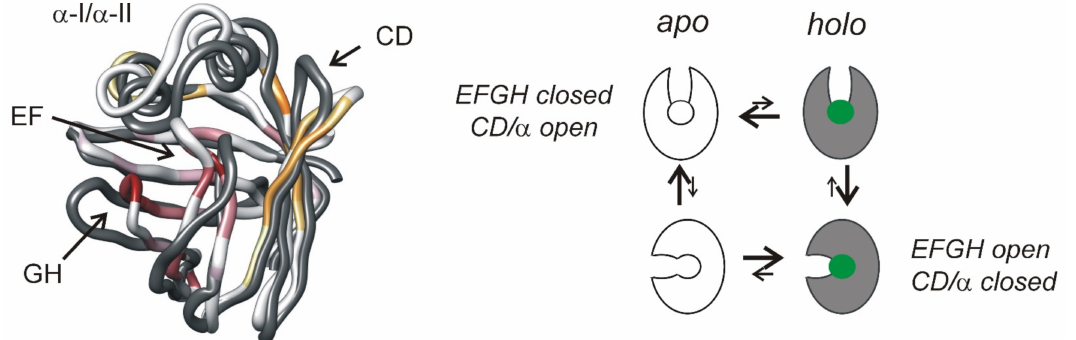
Figure 7. Proposed mechanism of bile salt entry. Superimposed backbone trace of the apo (PDB: 1o1u [39], white with color) and the holo form (PDB: 2mm3 [25], grey) of hI-BABP showing the enlarged gap between the E/F and G/H turns in the bound state connecting the binding cavity with the bulk phase. Note the accompanying closing of the helical cap upon bile salt binding. The color coding in the apo state reflects the chemical shift difference between the ground and the low- populated higher energy state inferred from the CPMG relaxation dispersion measurements (Figure 6) for the two clusters (orange and red) at pH = 6.3 with darker color corresponding to larger values of | ∆ ω EG |. Note the match between regions undergoing a large conformational rearrangement upon bile salt binding and the darker shades of orange and red reflecting a larger chemical shift difference between the exchanging states in the apo form. Cartoon of the conformational selection model of ligand binding is shown on the right. A conformational equilibrium between an EFGH closed -CD/ α open and an EFGH open -CD/ α closed state in the apo form is shifted toward the latter upon bile salt